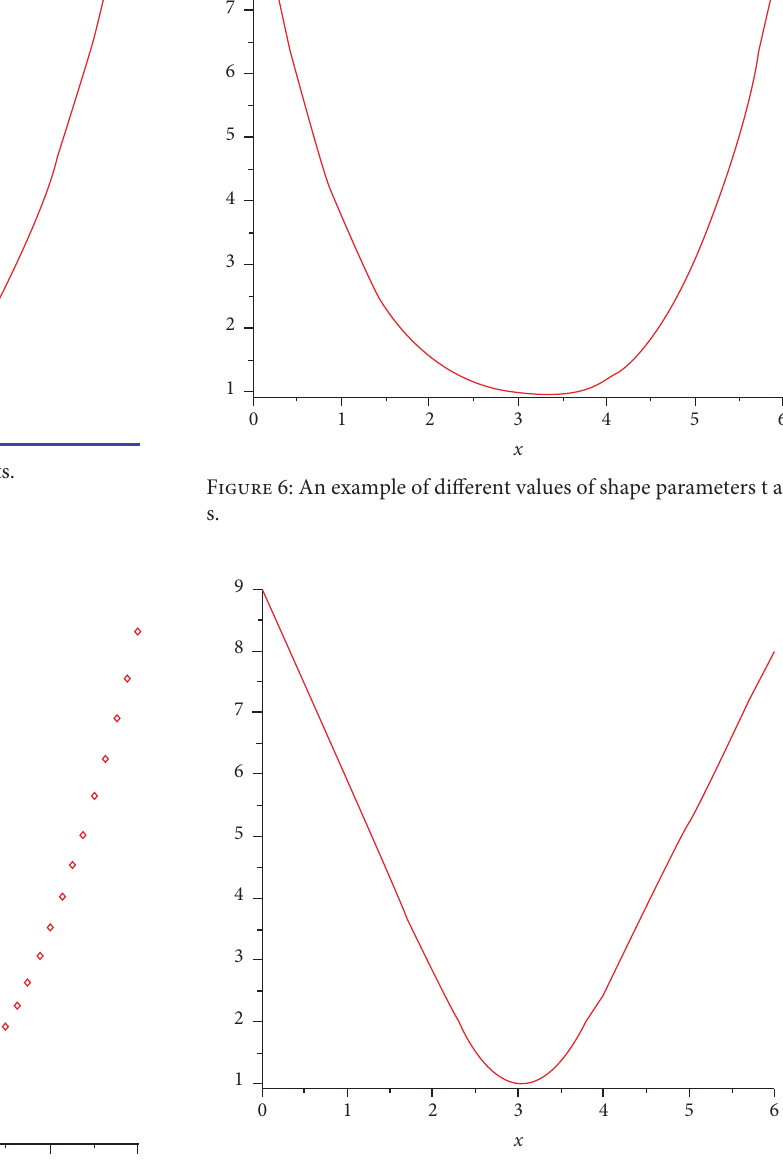
Figure 7: Impact of shape parameters t and as it moves away from connecting